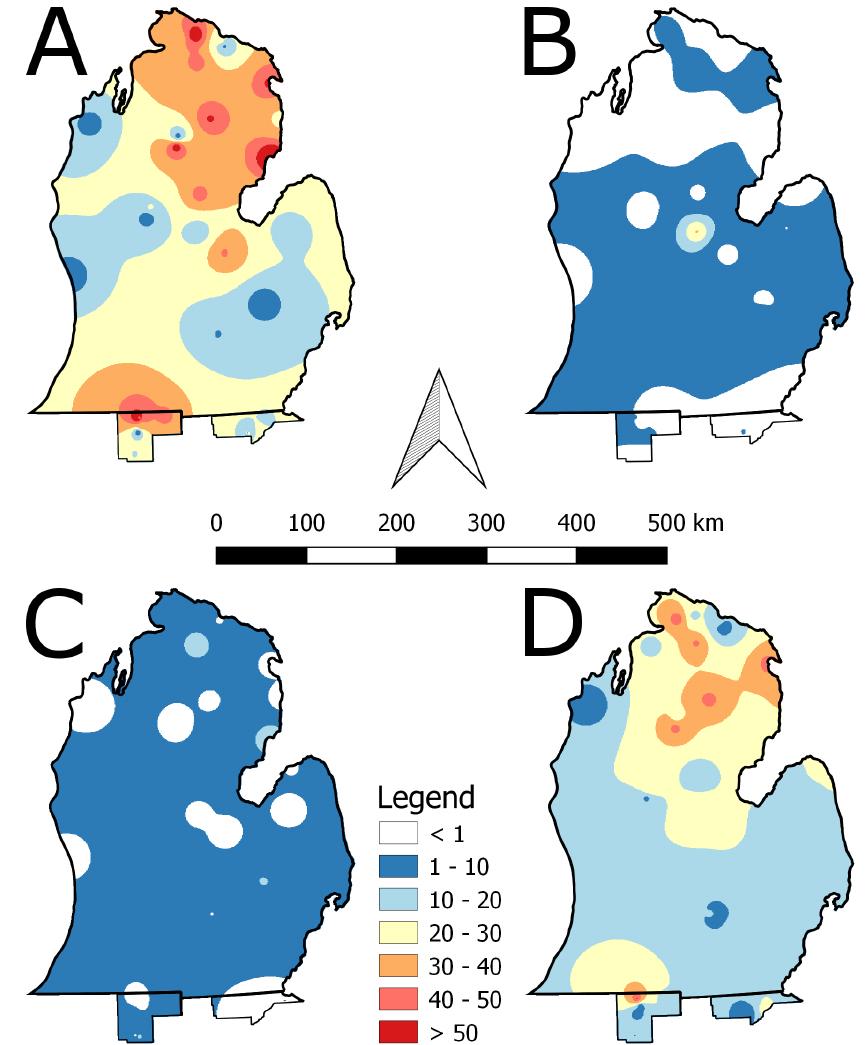
Figure 2. Inverse distance weighting interpolation of relative dominance (percent basal area) of ( A ) live ash in 2007, ( B ) dead ash in 2007, ( C ) live ash in 2017, and ( D ) dead ash in